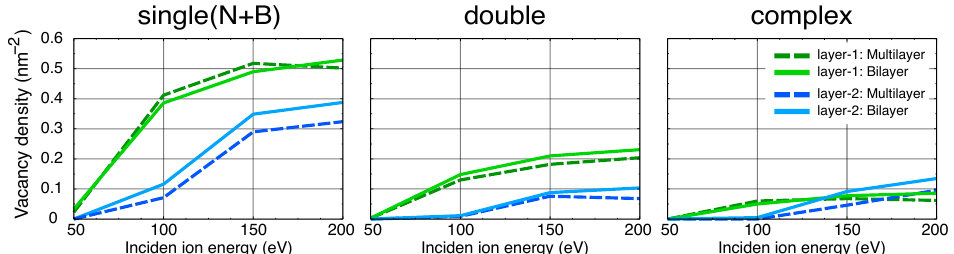
Figure 9. Comparison of defect production in a bilayer h-BN and the top two layers of the multilayer target under high fluence (5 × 10 14 ions/cm 2 ) Argon ion irradiation. The solid lines stand for the bilayer system and the dashed lines represent the multilayer target, and the types of the vacancies are shown above each